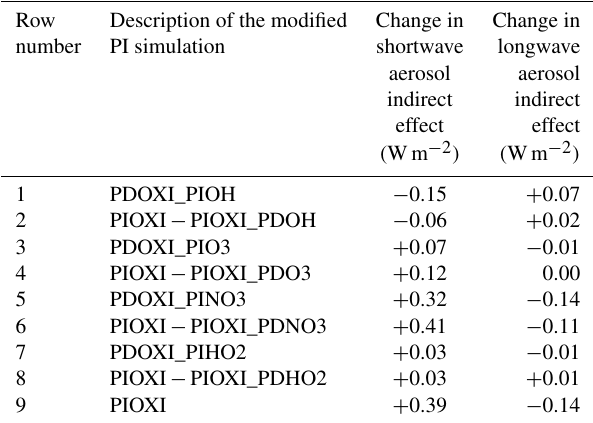
Table 6. Difference in global mean SW and LW indirect effects between setups with the modified PI simulation in the second col- umn and the default PI simulation with PD oxidants. The bottom row shows the effect of changing all of the oxidants at the same time (similar to Fig. 3c and d), the other odd numbered rows show the effect of changing one oxidant at the time in the PI simulation, while the even numbered rows show the difference in switching all oxidants (PIOXI) and all but one (PIOXI_PDXXX) in the PI simu-